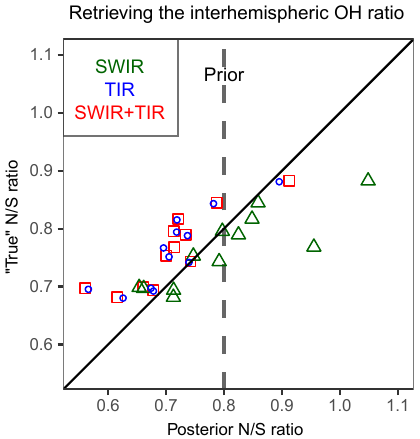
Figure 12. Ability of the inversion of satellite methane ob- servations to retrieve the interhemispheric OH ratio defined by (cid:14) τ OH,SH τ OH , NH . Posterior inversion results using SWIR, TIR, or CH 4 CH 4 SWIR + TIR observations are compared to the true ratio from 12 different model OH distributions (Fig. 9). The dashed vertical line (cid:14) τ OH,SH represents the prior τ OH , NH ratio common to all inver- CH 4 CH 4